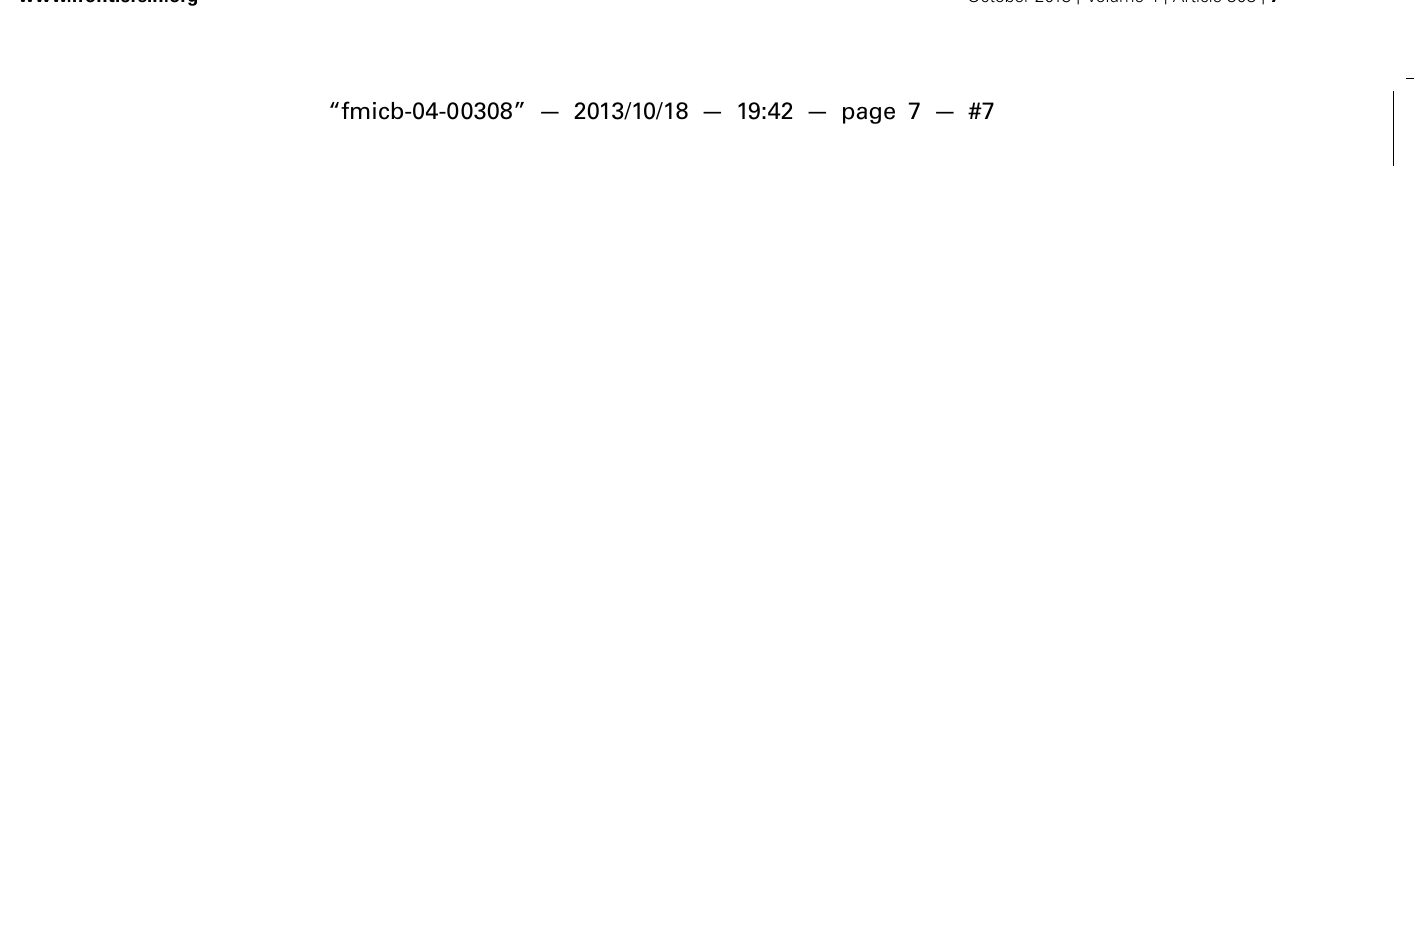
FIGURE 1 | Nod1 and Nod2 signaling. Nod1 and Nod2 are activated by the peptidoglycan components iE-DAP and MDP, respectively. Recognition of PAMPs triggers TRAF6, RICK/RIP2, TAB 2/3, and TAK1. These can signal downstream to two major signaling networks: (1) MAP